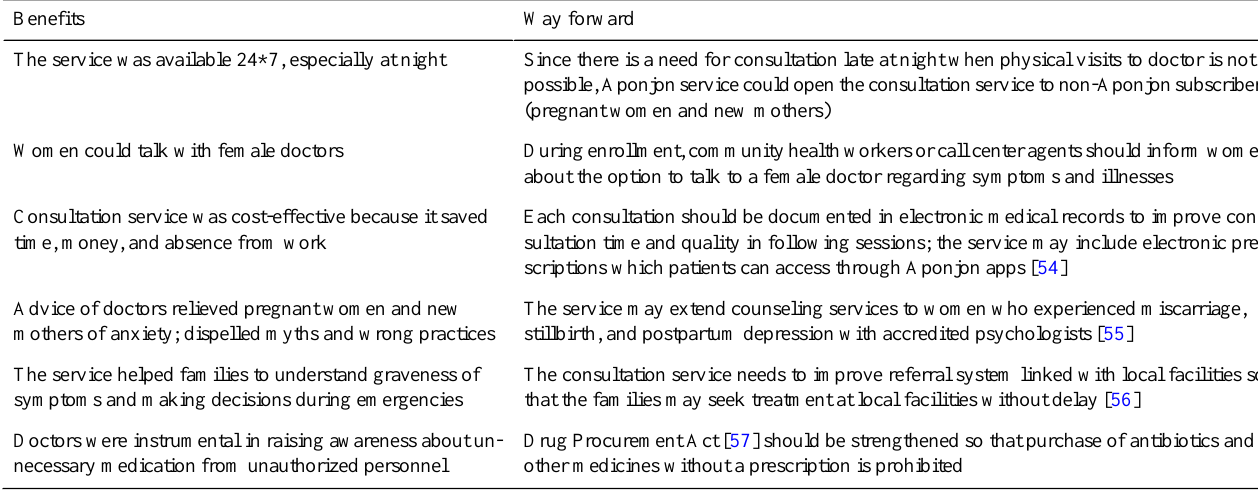
Table 6. Identified benefits and ways forward.